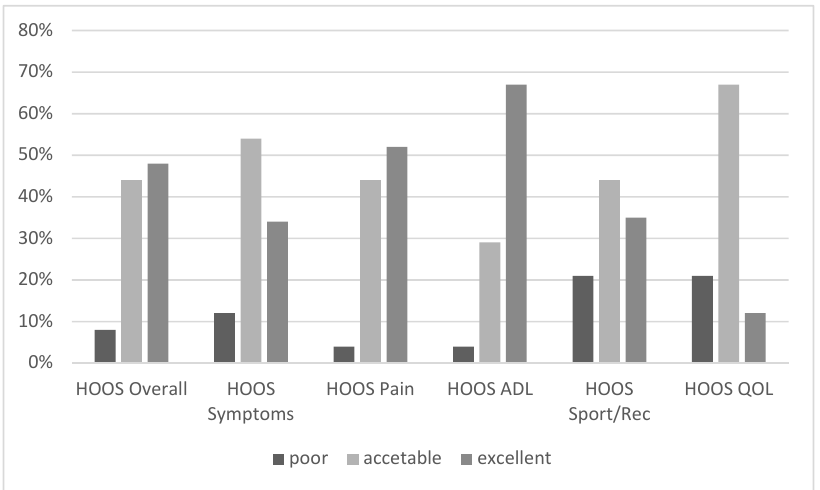
Figure 3. HOOS score. Outcomes were considered excellent for HOOS > 90 points, acceptable for 60 ≤ HOOS ≤ 90 points, and poor for HOOS < 60 points, in each domain.